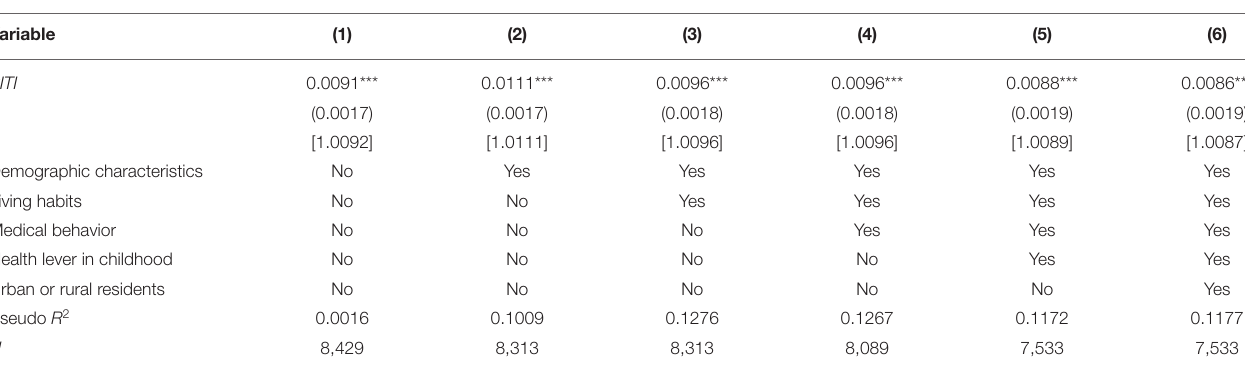
TABLE 8 | Stepwise Regression for actual_HL .